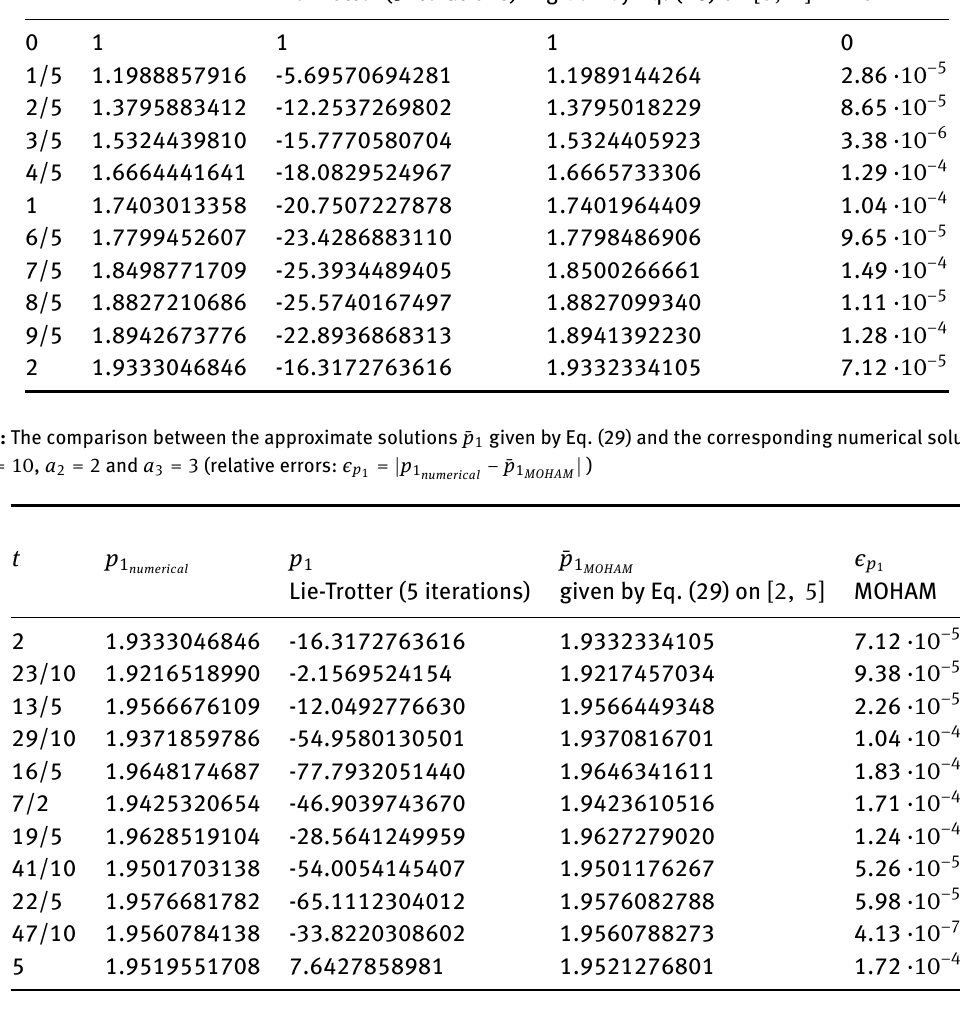
− ¯ p 1 | ) MOHAM numerical